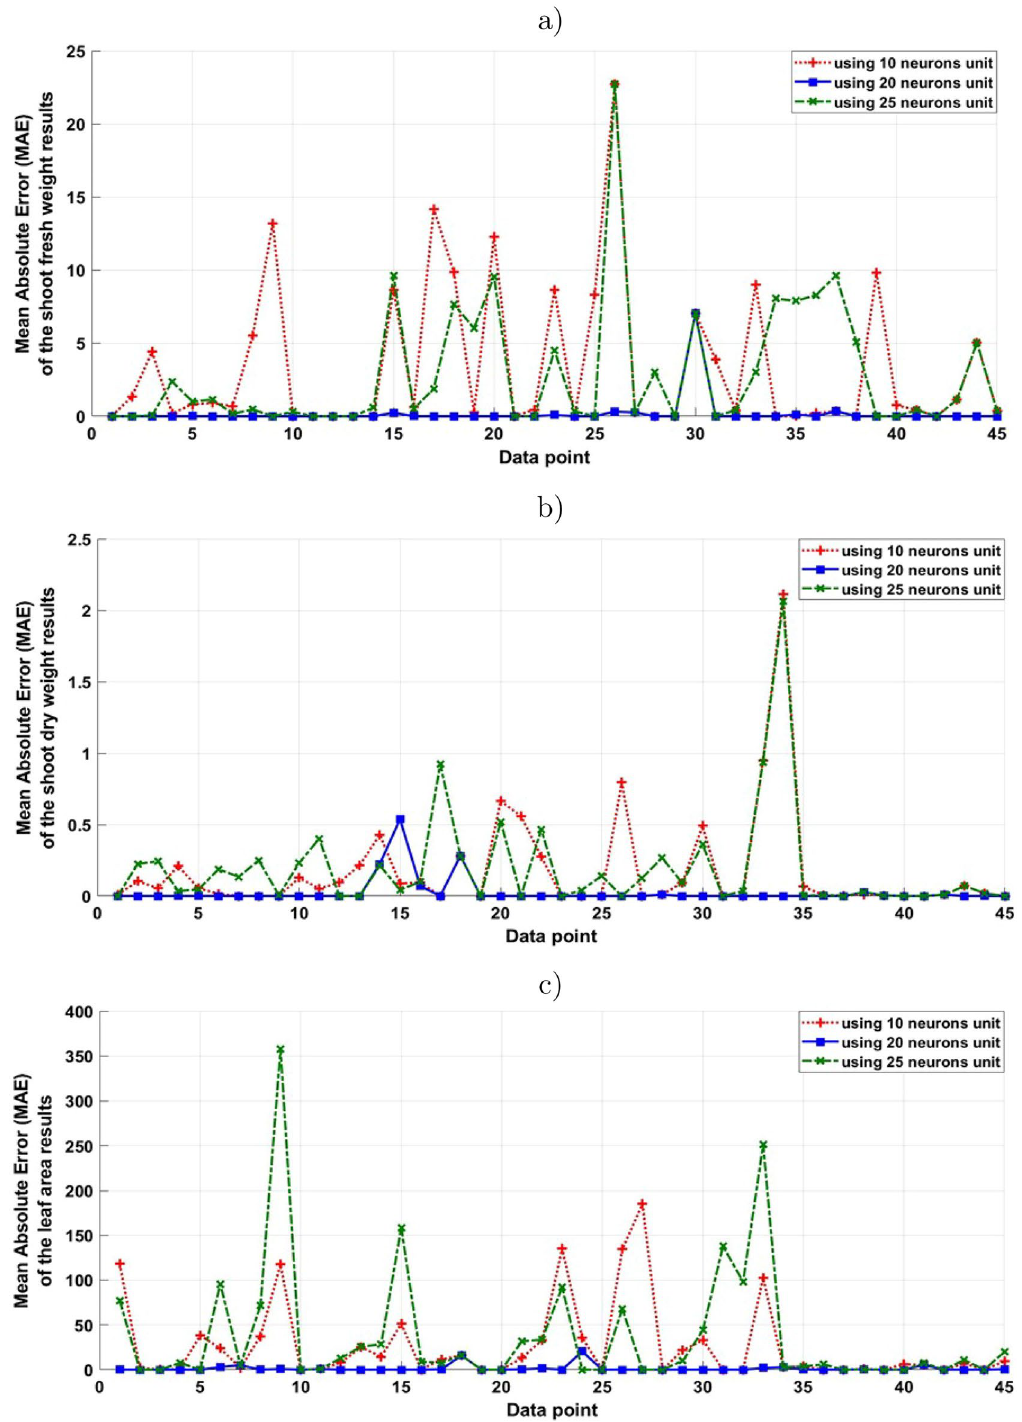
Figure 6. The mean absolute error values for the achieved results of using 10, 20 and 25 neuron units in the hidden for predicting the daily growth rate of ( a ) shoot fresh weight, ( b ) shoot dry weight, ( c ) leaf area in the